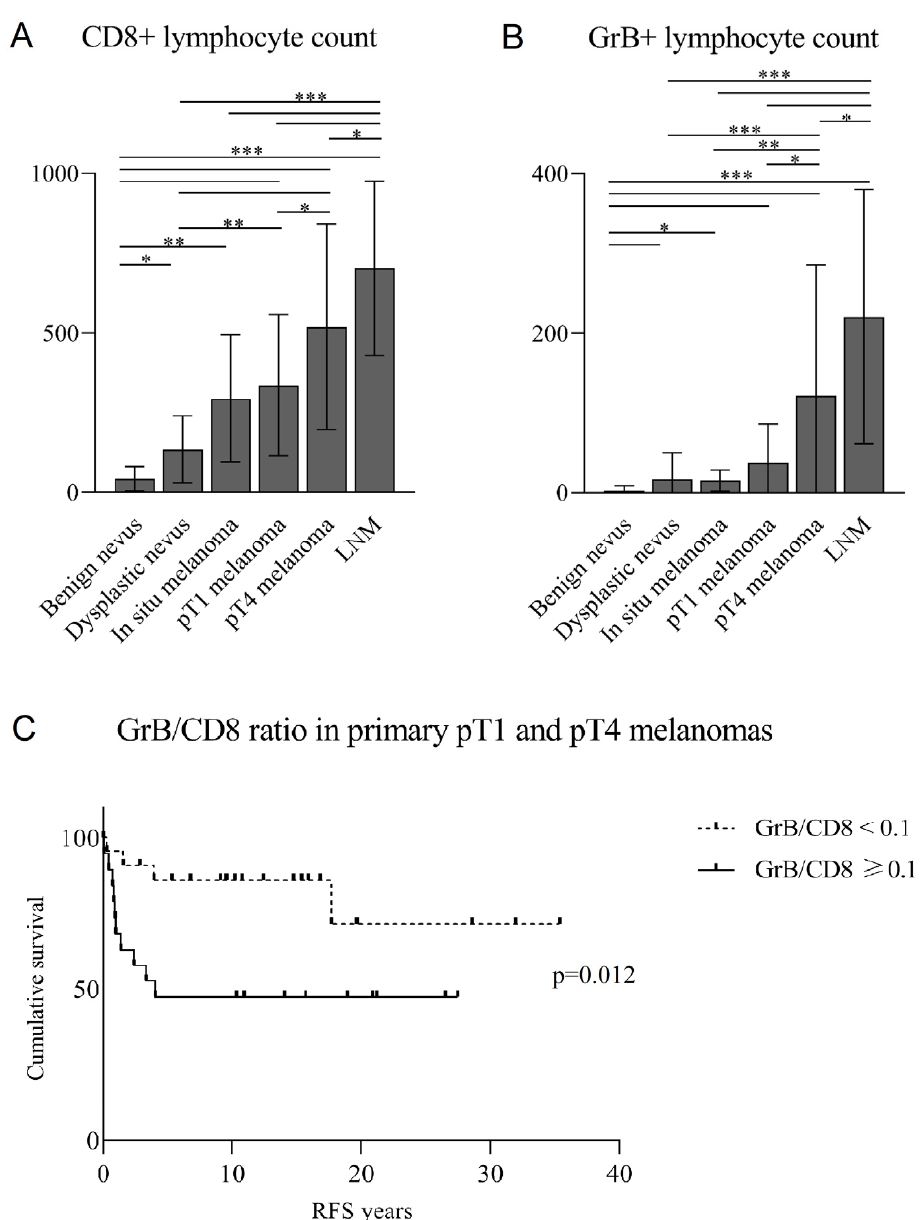
Figure 3. Mean counts of CD8+ lymphocytes ( A ) and GrB+ lymphocytes ( B ) analyzed using hotspot method, and the association of GrB/CD8 lymphocyte ratio with RFS in primary melanomas ( C ). CD8+ lymphocytes were analyzed from 203, and GrB+ lymphocytes from 172 tumor samples. The data in ( A , B ) represent mean ± SD. Statistically significant differences between the groups in ( A , B ) are shown with connecting lines (Kruskal–Wallis test). * p < 0.05, ** p < 0.01, *** p < 0.001. p -value in ( C ) represents the p -value obtained by Cox Regression analysis. pT = pathological tumor stage, LNM = lymph node metastasis, RFS = recurrence-free survival. In melanocytic tumors, there was a positive correlation between CD8+ and GrB+ lymphocytes (Spearman’s rho r s = 0.829, p < 0.001) (Table 4).